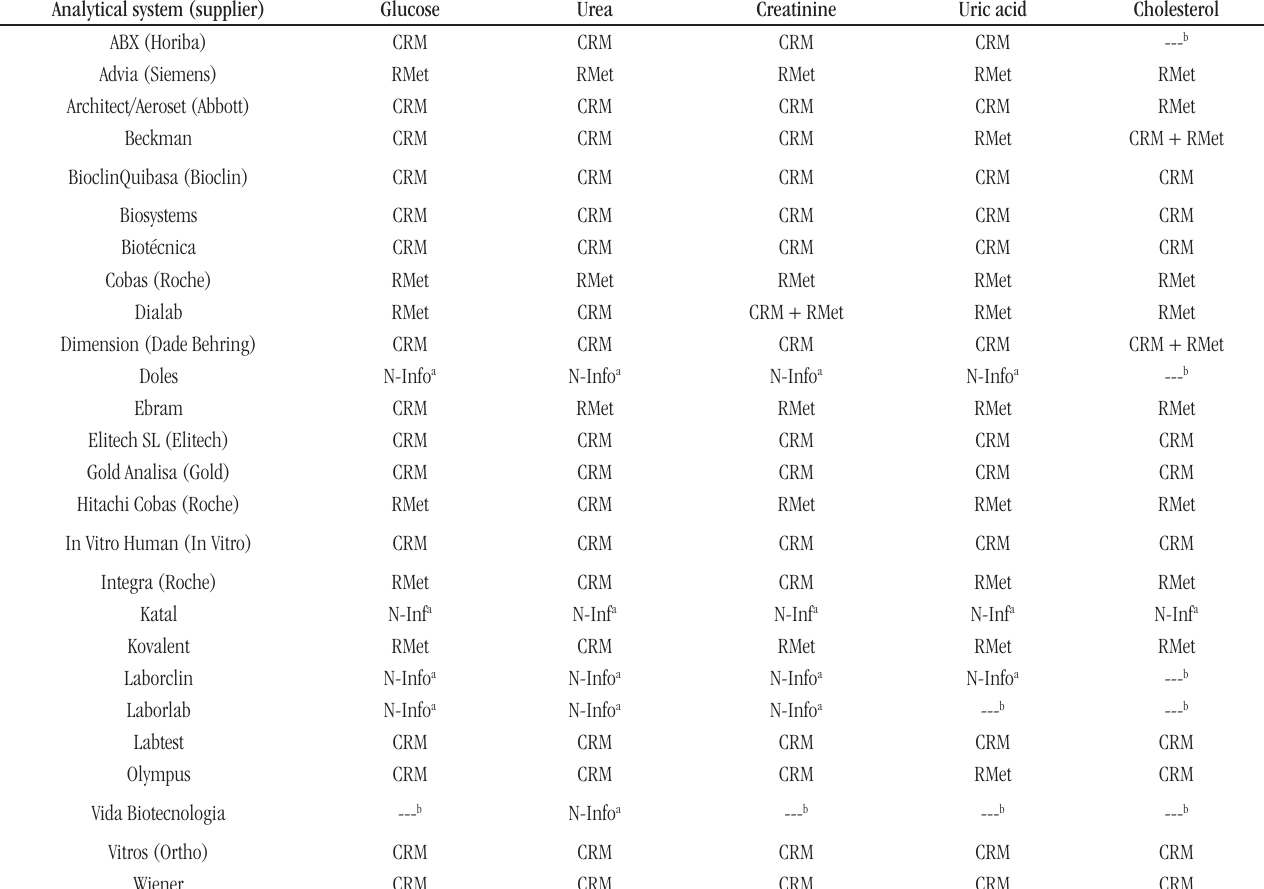
taBLE 6 − Metrological traceability of analytical systems reported by laboratories participating in the proficiency testing program Analytical system (supplier)